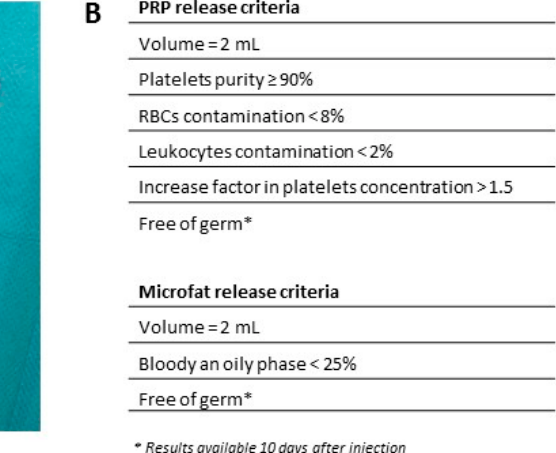
Figure 2. ( A ) Microfat-PRP investigational Advanced Therapy Medicinal Product (ATMP) delivered to the operating room for intra articular injection in radio-carpal joint (without labelling). ( B ) Release criteria from PRP and microfat checked by the responsible pharmacist from the ATMP